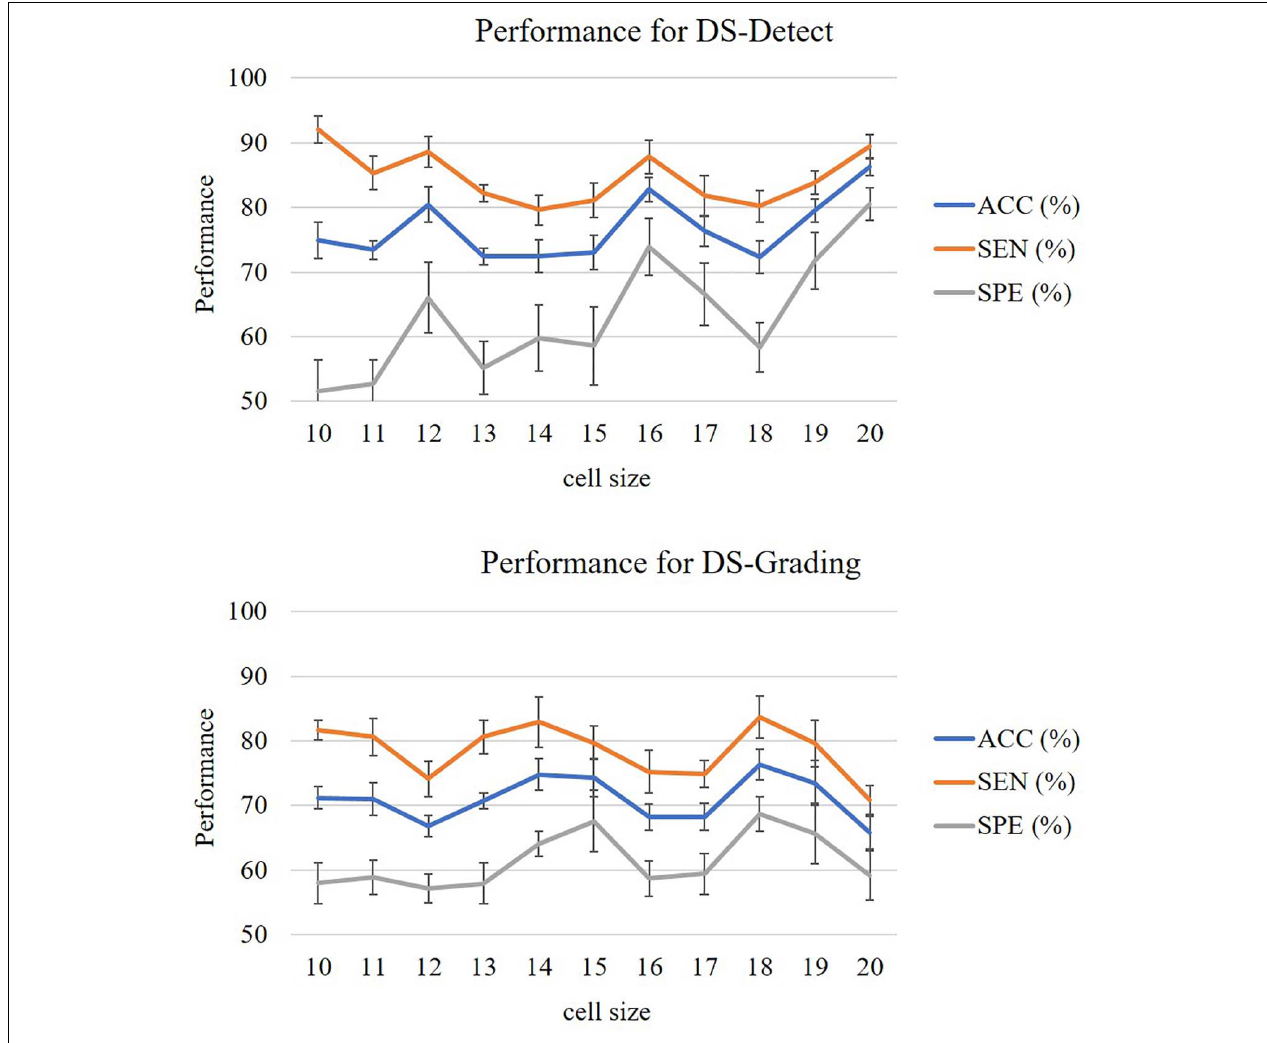
FIGURE 3 | Performance of glioma detection and glioma